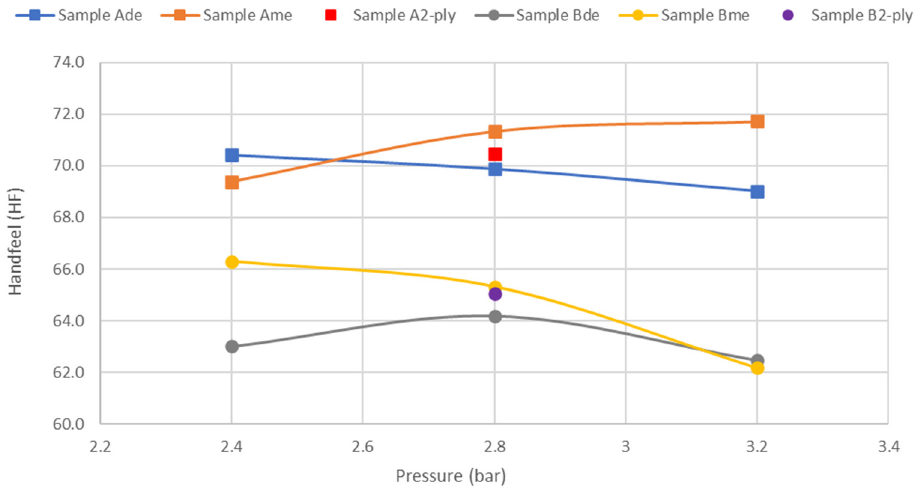
Figure 10. Results obtained for handfeel (HF) with the pressure increase in the samples A and B with deco and micro embossing.